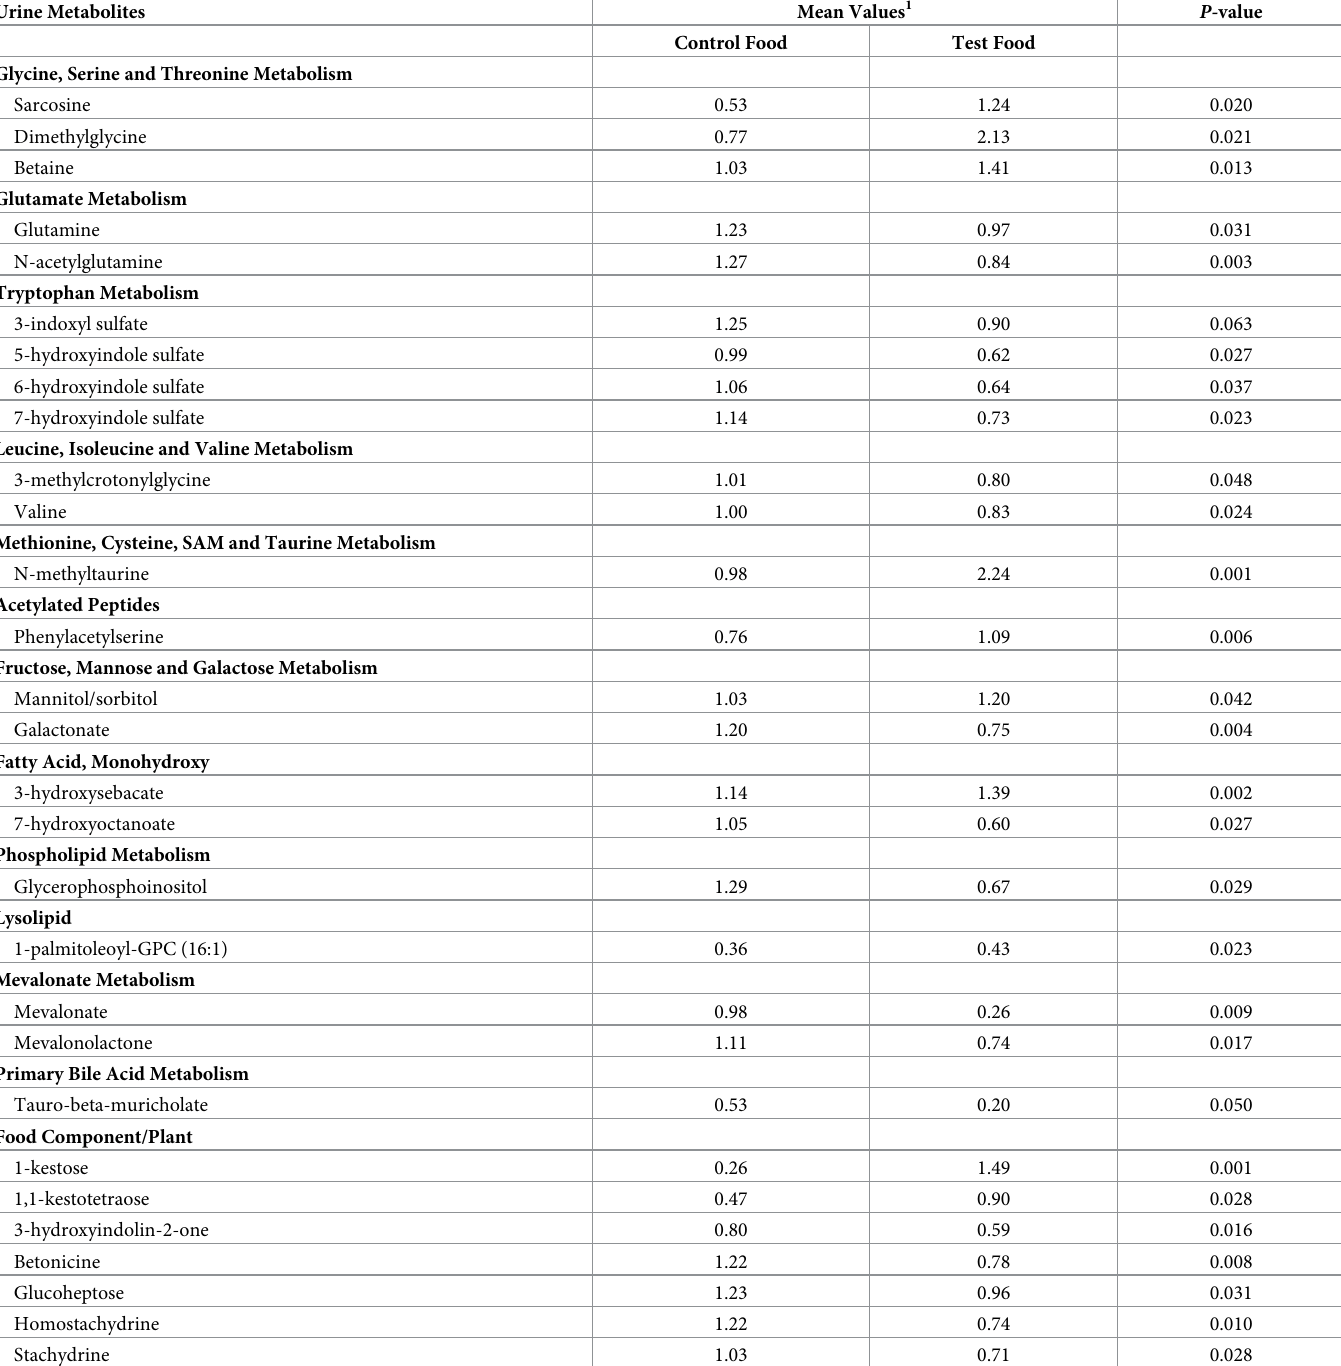
Table 5. Relative concentrations of urine metabolites that were significantly different ( P � 0.05) in cats with Chronic Kidney Disease (CKD) after feeding control food or test food for 8 weeks in a crossover feeding trial (N =